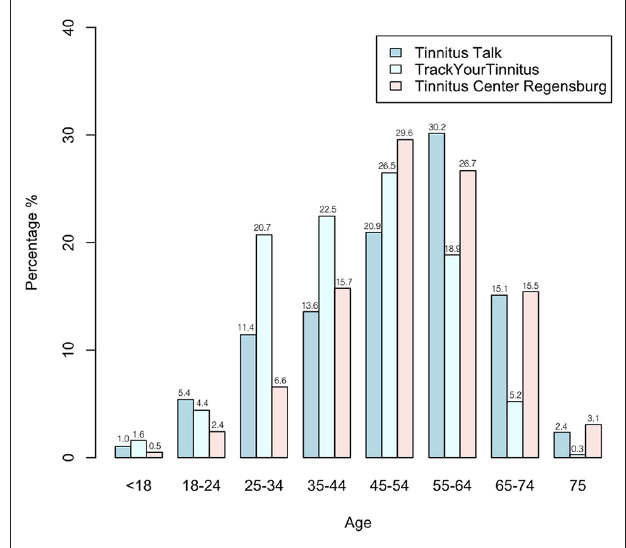
TABLE 1 | Description of the three samples and comparisons between the samples.